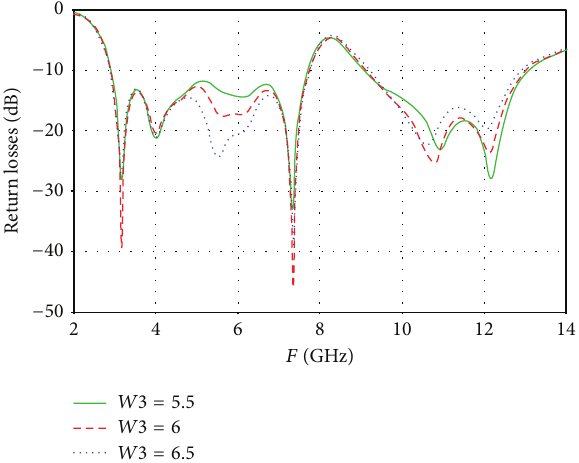
Figure 7: Simulated return losses for the proposed UWB antenna with different 𝐿3